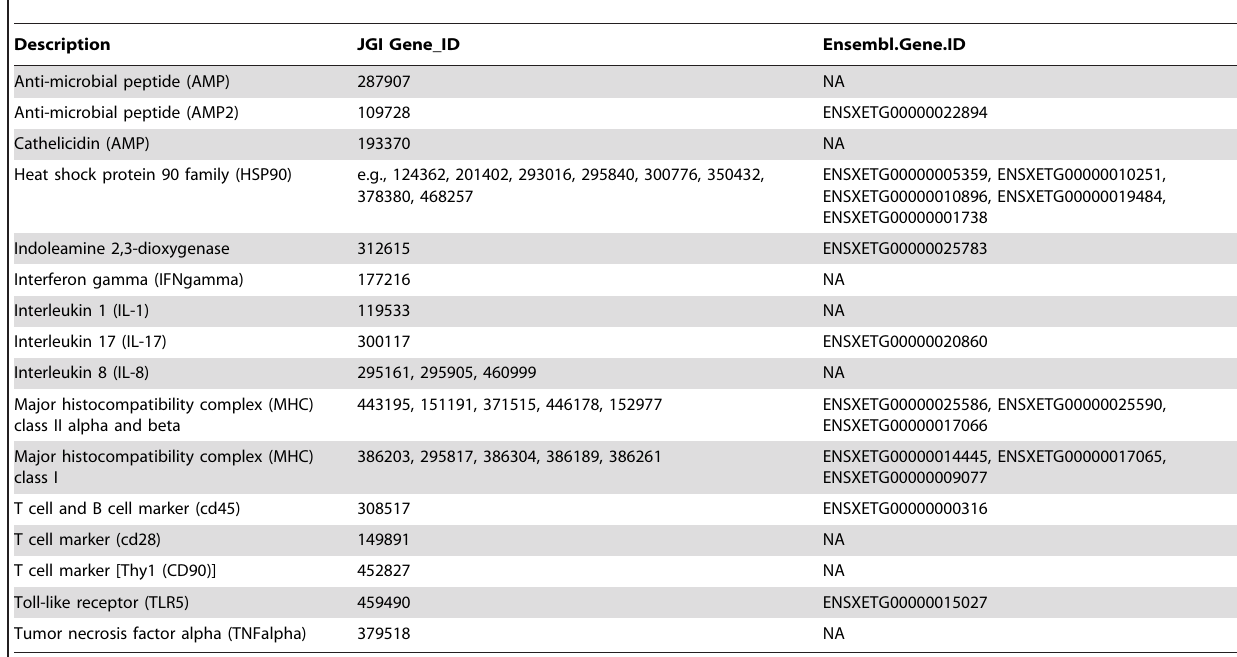
Table 2. Examples of genes expected to be involved in a robust immune response that showed unchanged expression between infected and control